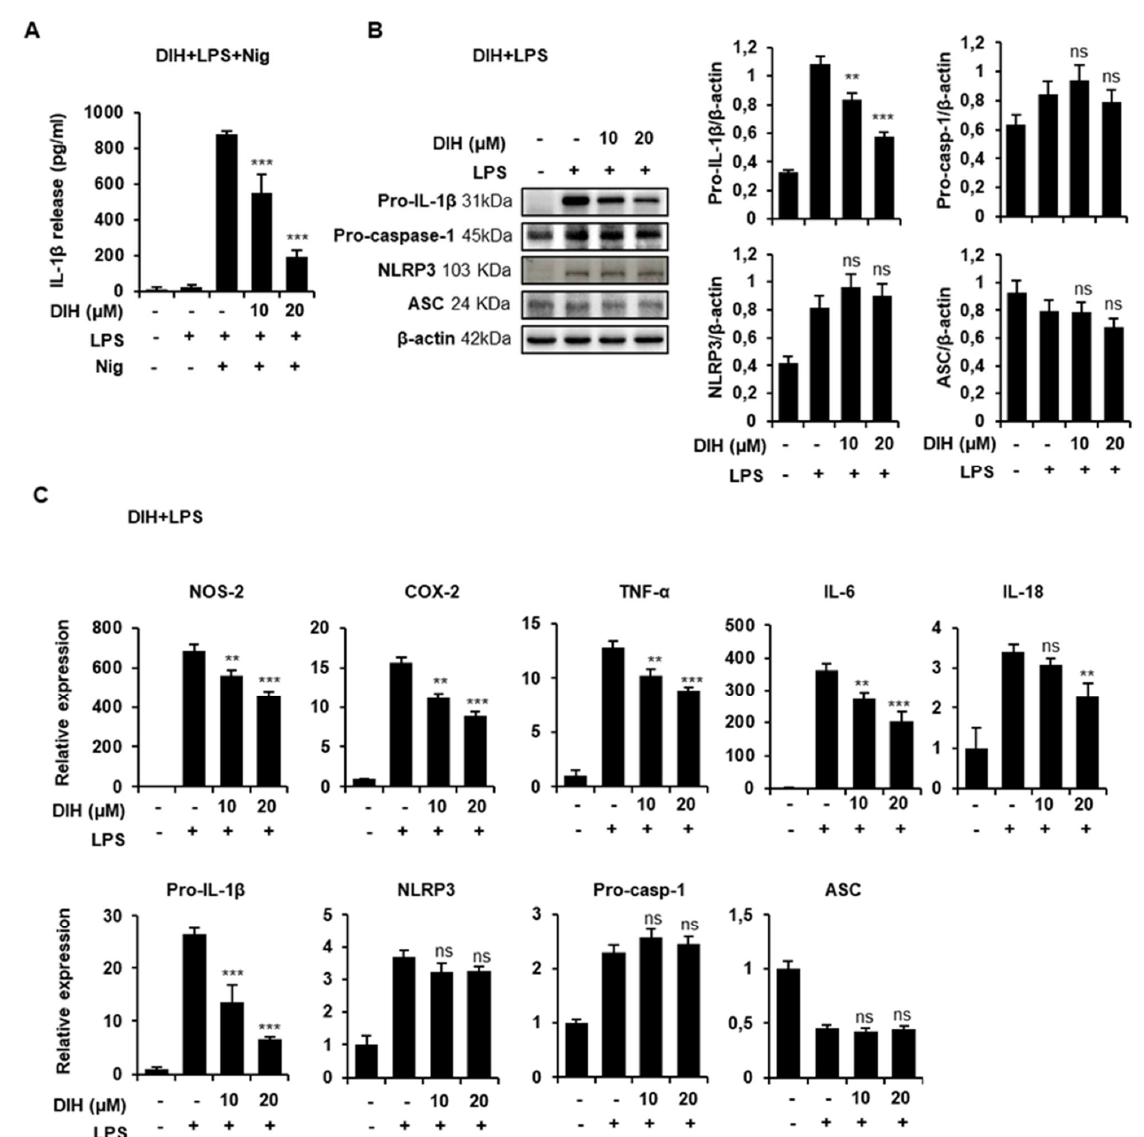
Figure 6. DIH regulates the priming step of NLRP3 inflammasome activation. ( A ) Levels of IL-1β were measured using ELISA in the culture medium from J774A.1 cells stimulated with LPS (1 μg/mL, 4 h), followed by treatment with DIH (10, 20 μM, 30 min) and then Nig (20 μM, 1 h). Results show the means ± SD (n = 3). *** p < 0.001 vs. LPS + Nig treatment. ( B ) J774A.1 were preincubated with DIH (10, 20 μM, 30 min) and then stimulated with LPS (1 μg/mL, 4 h). Relative expression of mRNA levels of inflammatory mediators and inflammasome complex components were measured by qPCR. Results are expressed as means ± SD of three independent experiments. ( C ) Immunoblot analysis of cell lysates for pro-IL-1β (31 kDa), pro-caspase-1 (45 kDa), NLRP3 (103 kDa) and ASC (24 kDa) expression, using β-actin as a loading control. Densitometry analysis shows the mean ± SD of the western blot experiments. ns = not significant, ** p < 0.01, *** p < 0.001 vs. LPS treatment.